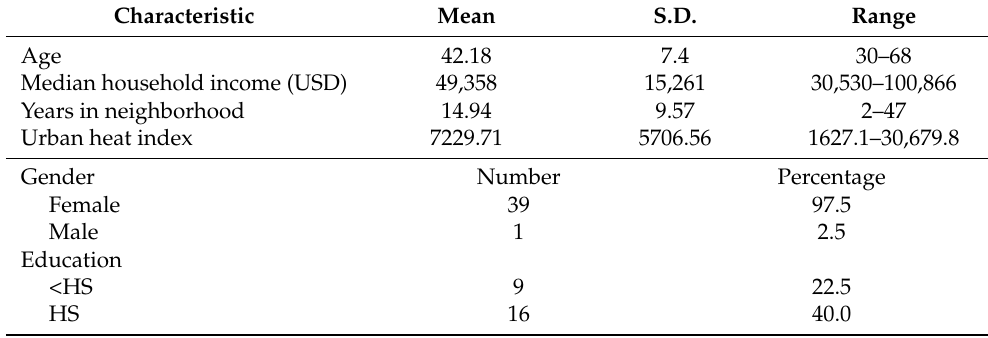
Table 1. Demographic characteristics and heat adaptation resources of study participants (n =